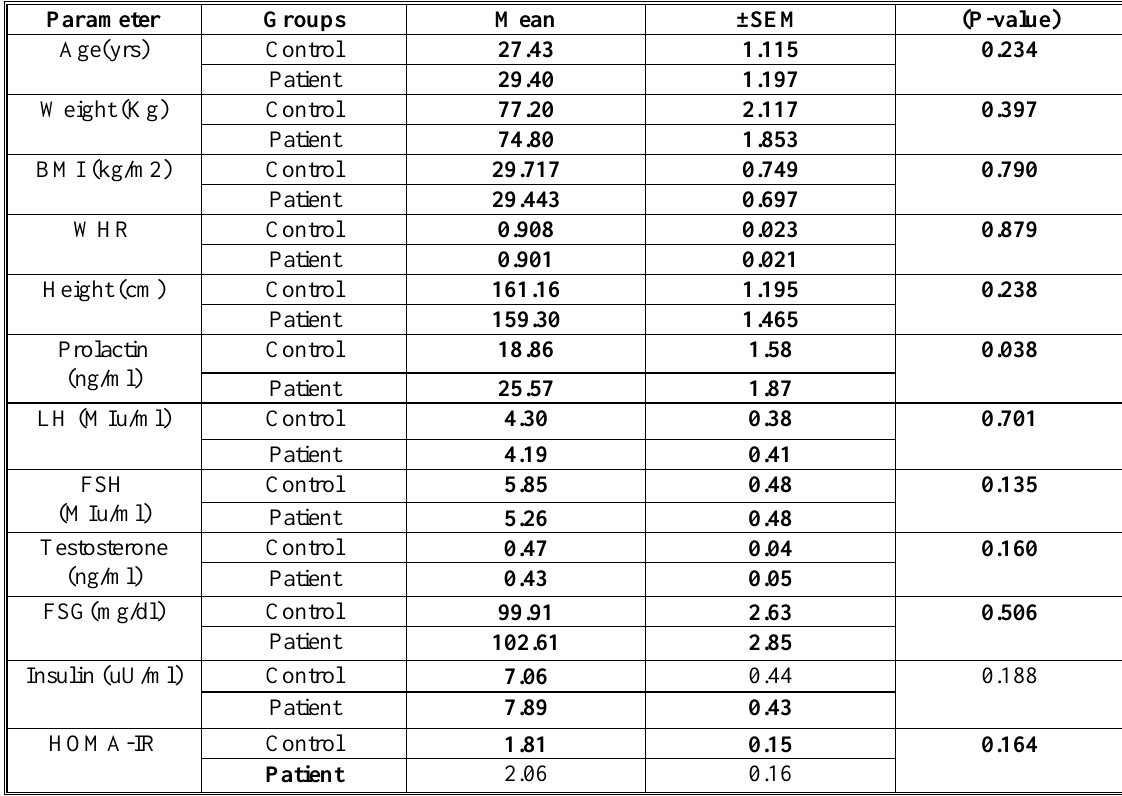
Table 1 . Subjects